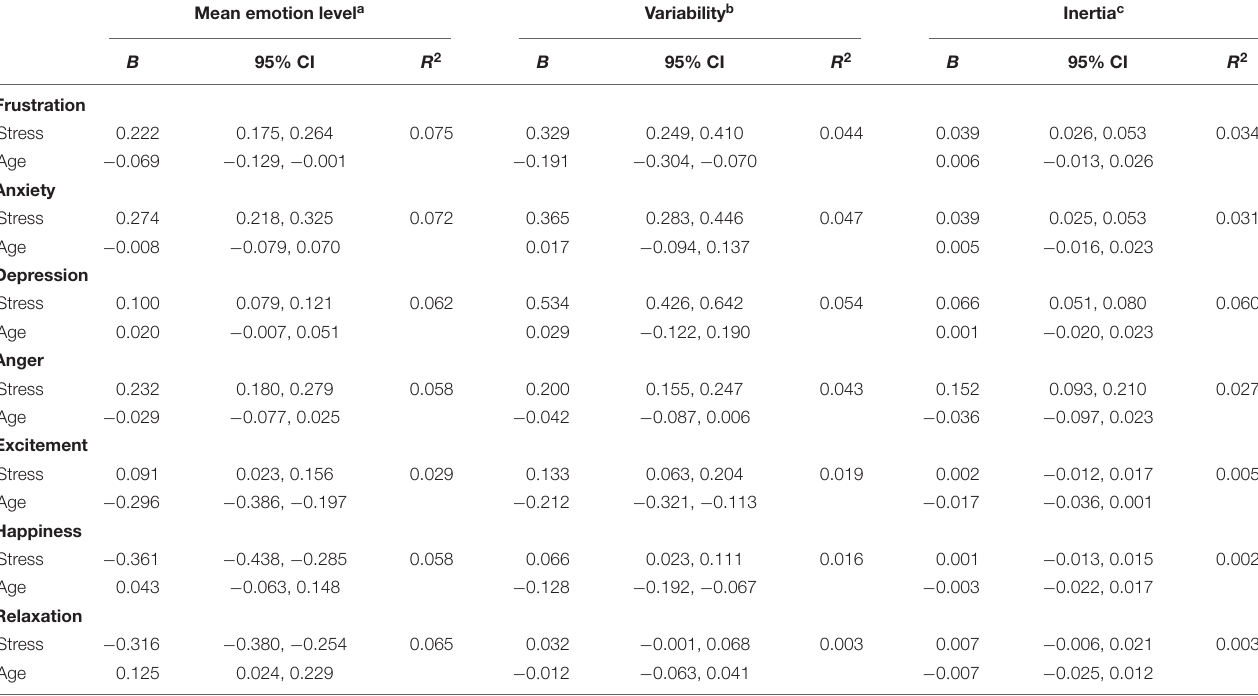
TABLE 2 | Effect sizes of perceived stress and age on mean, variability, and inertia of each emotional state. Mean emotion level a Variability b Inertia